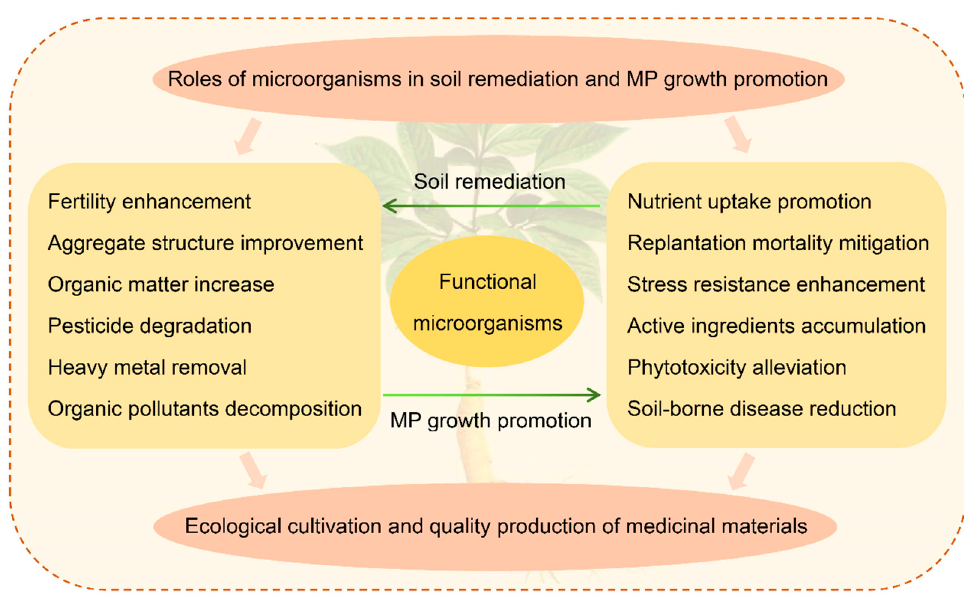
Figure 1. Functions of microorganisms in soil remediation and MP growth promotion.